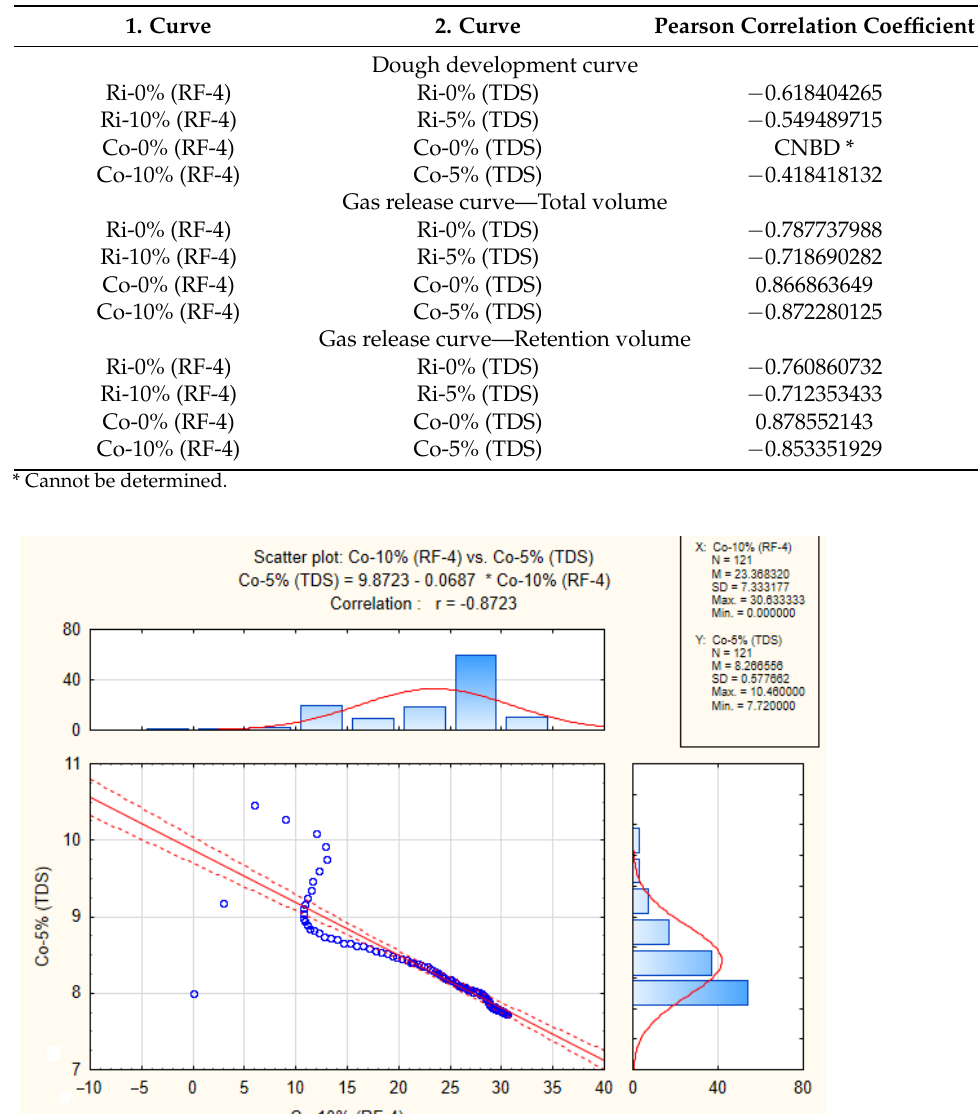
Table 3. Correlation of curves (time series) measured with the experimental TDS and professional Rheofermentometer RF-4.